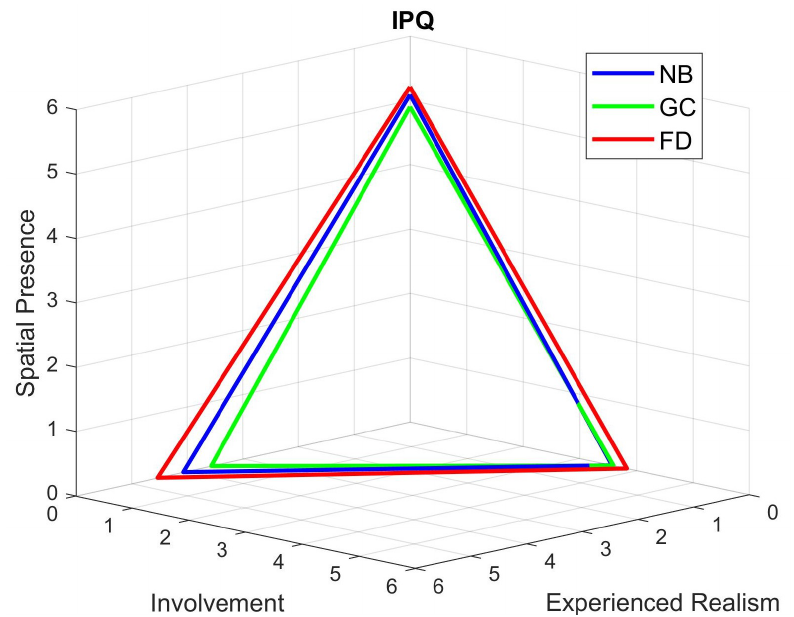
Figure 13. IPQ scores for the cybersickness experiment (conditions: NB—No Blur; GC—Unity Blur; FD—Ours). The questionnaire was filled after each session. NB: Involvement 3.57, Experienced Realism 4.07, Spatial Presence 5.09; GC: Involvement 3.60, Experienced Realism 3.57, Spatial Presence 4.90; FD: Involvement 3.83, Experienced Realism 4.53, Spatial Presence